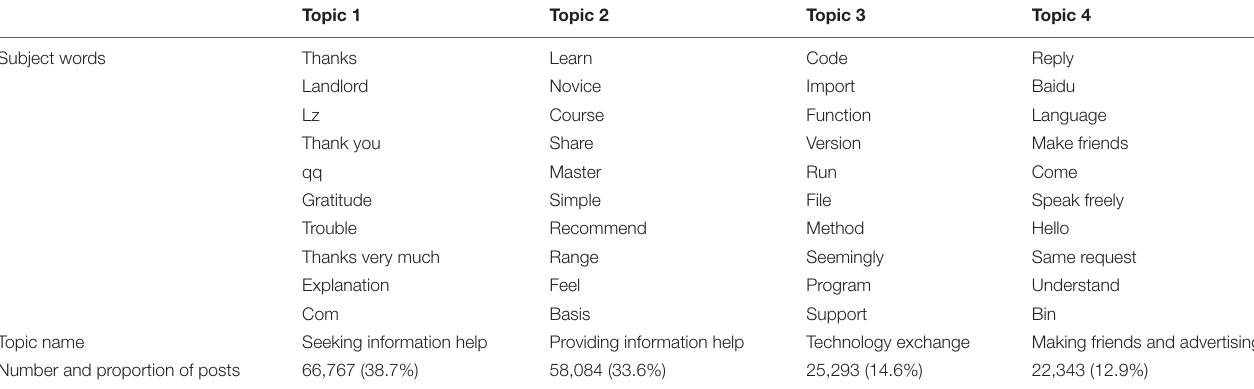
TABLE 2 | Topic information for female users.